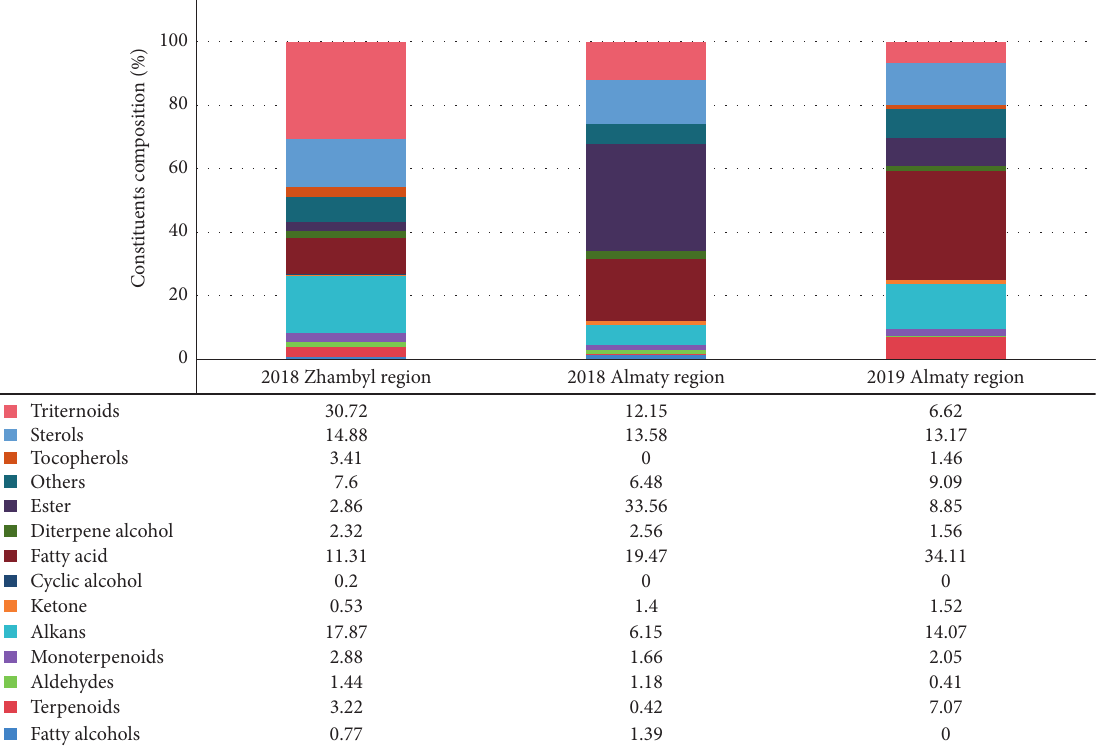
2 extracts of different origin and time of raw material